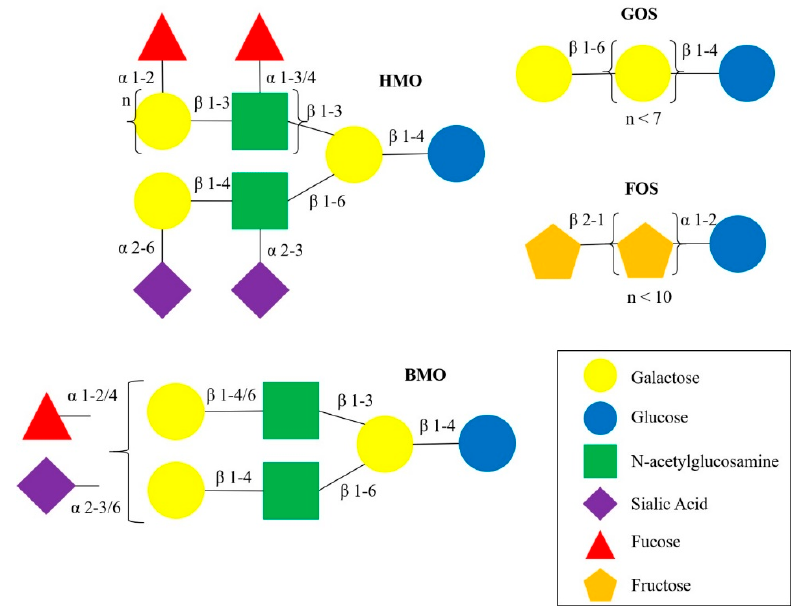
Figure 1. Structural schematics of HMO, BMO, GOS and FOS.The HMO structure is more complex and diverse compared to BMO and plat-derived oligosaccharides, GOS and FOS. HMO and BMO structures can be branched with various α - and β -linkages, GOS and FOS contain linear chains of repeating units of galactose ( n < 7) and fructose ( n < 10), respectively. Abbreviations: HMO, human milk oligosaccharide; BMO, bovine milk oligosaccharide; GOS, gallacto-oligosaccharide; FOS, fructo-oligosaccharide.